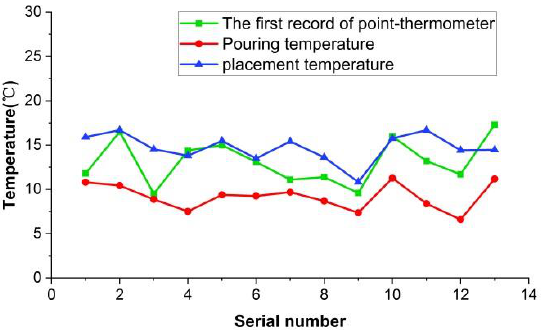
Figure 9. Comparison of pouring temperature, placement temperature, and the first records of point- thermometers.